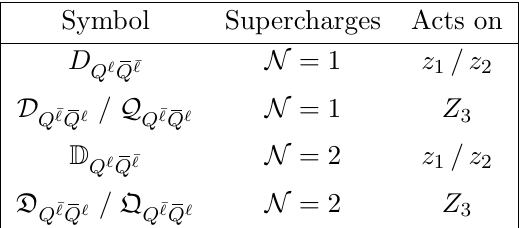
Table 1 . Reminder for the notation of di(cid:11)erential operators. The alternatives in the (cid:12)rst column represent the di(cid:11)erential operator obtained by acting on the (cid:12)rst / second operator,